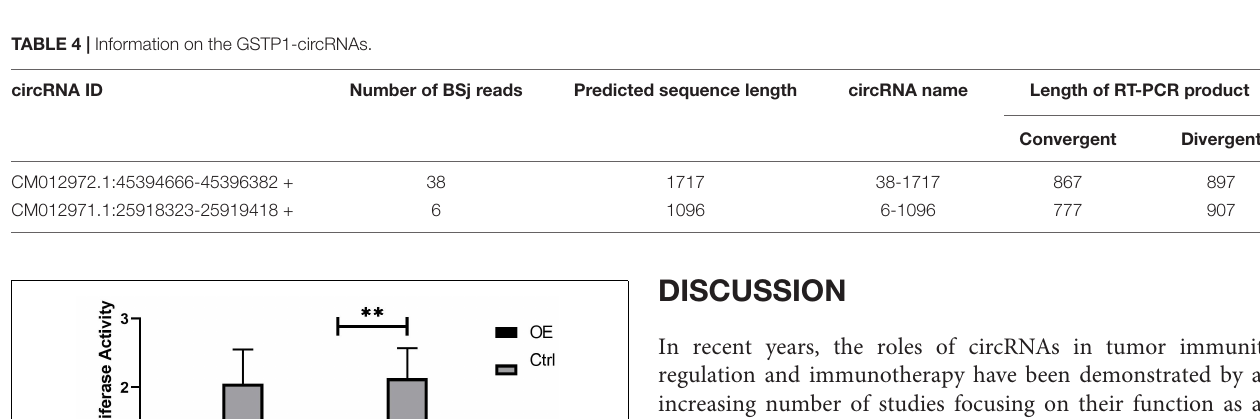
FIGURE 6 | CircRNA analysis for GSTP1. (A) Network of mRNA, miRNAs, and circRNAs. (B) Amplification result of RT-PCR for 38-1717 and 6-1096. (C) Combination of circRNAs and miRNAs.